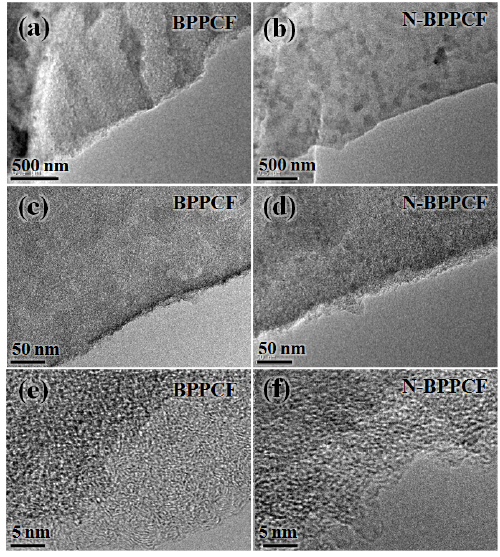
Figure 2. Transmission electron microscopy (TEM) and high-resolution TEM (HRTEM) images at different magnifications of ( a , c and e ) BPPCF and ( b , d and f ) N-BPPCF.